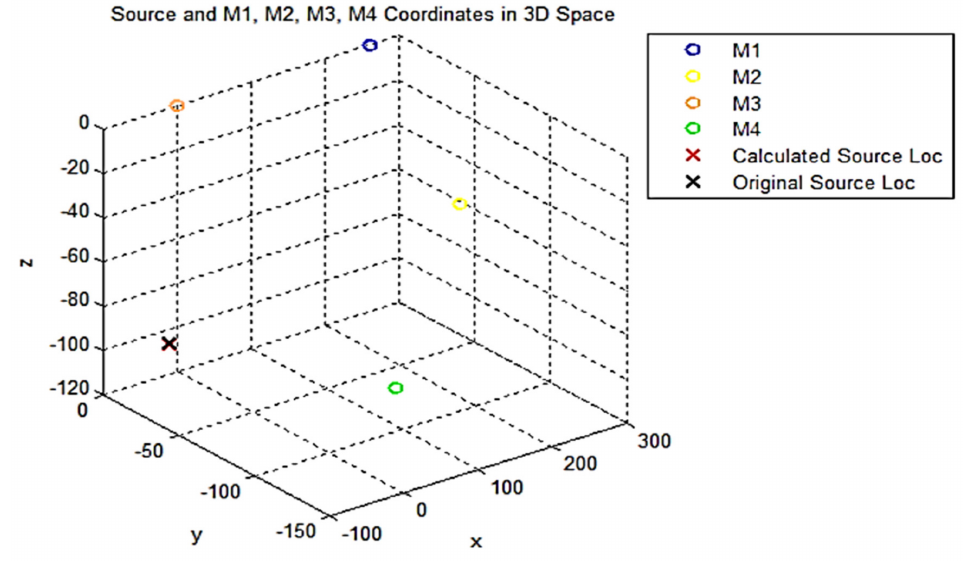
Figure 14. 3D model with source at ( − 30, − 10, −